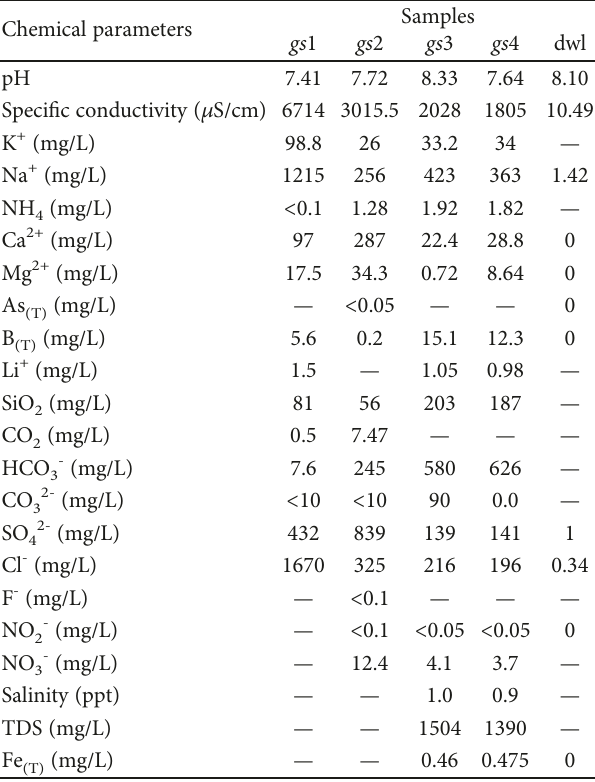
Table 1: Chemical properties of geothermal spring water samples and distilled water